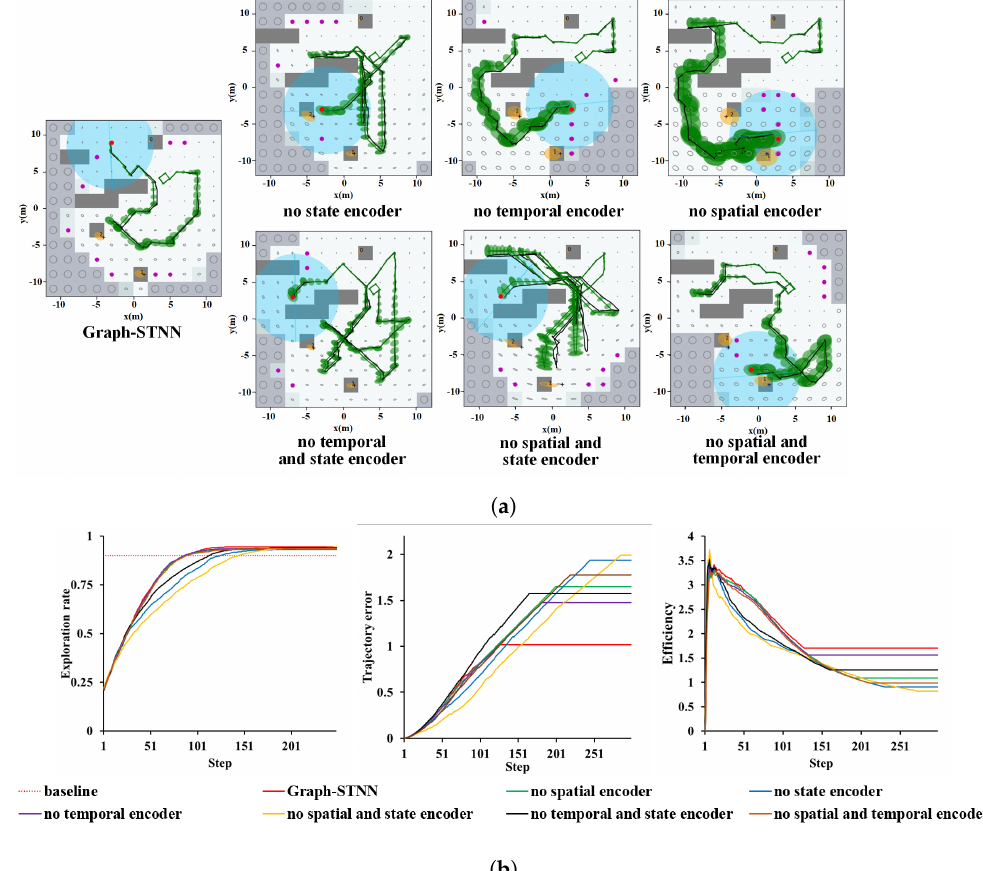
Figure 13. The results of 50 exploration trials of Graph-STNN and the removal of its components, with the model trained in 20 m × 20 m maps and the same initialized landmarks and robot’s start locations, on 20 m × 20 m maps. ( a ) One of the test result of 50 exploration trials. ( b ) Average exploration rate (left), trajectory error (middle), and exploration efficiency